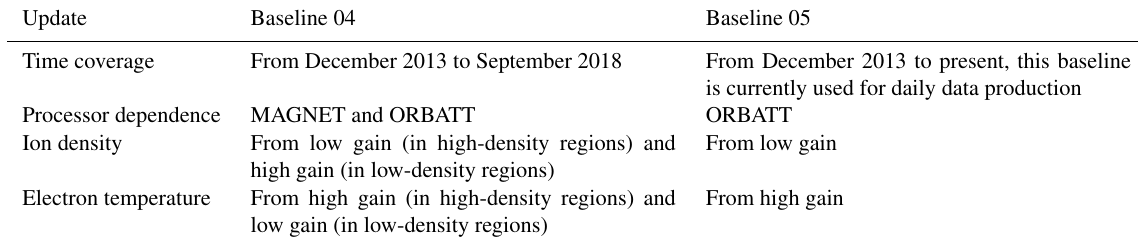
Table 2. Main differences between baseline 04 and baseline